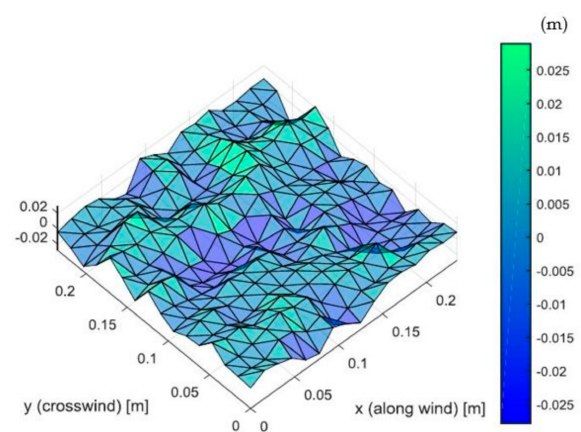
Figure 3. 3D water surface model triangulated by Delaunay triangulation.